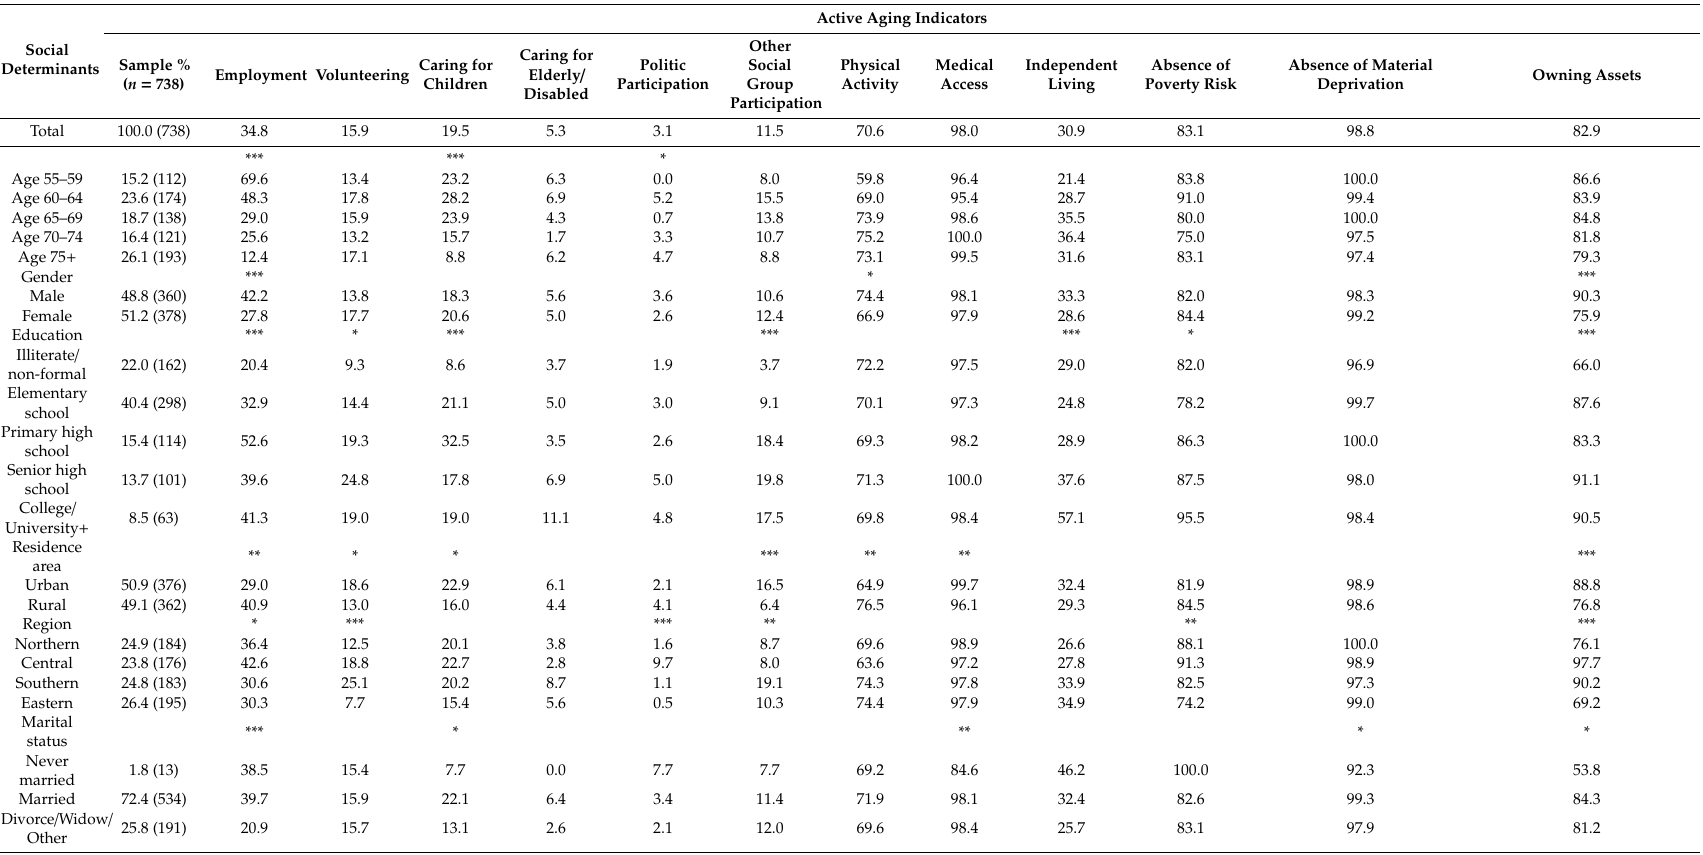
Table 1. Sample description and distribution of active aging indicators by social determinants